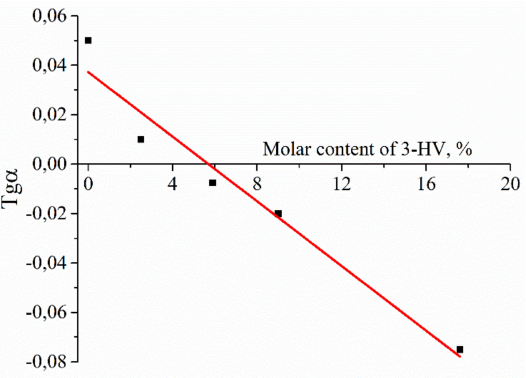
Figure 6. The e ff ect of the 3-HV molar content in the PHBV chain on the crystallinity degree of the copolymers in the degradation process in the lipase solution for 6 months, in the coordinates of the slope of the incubation time.